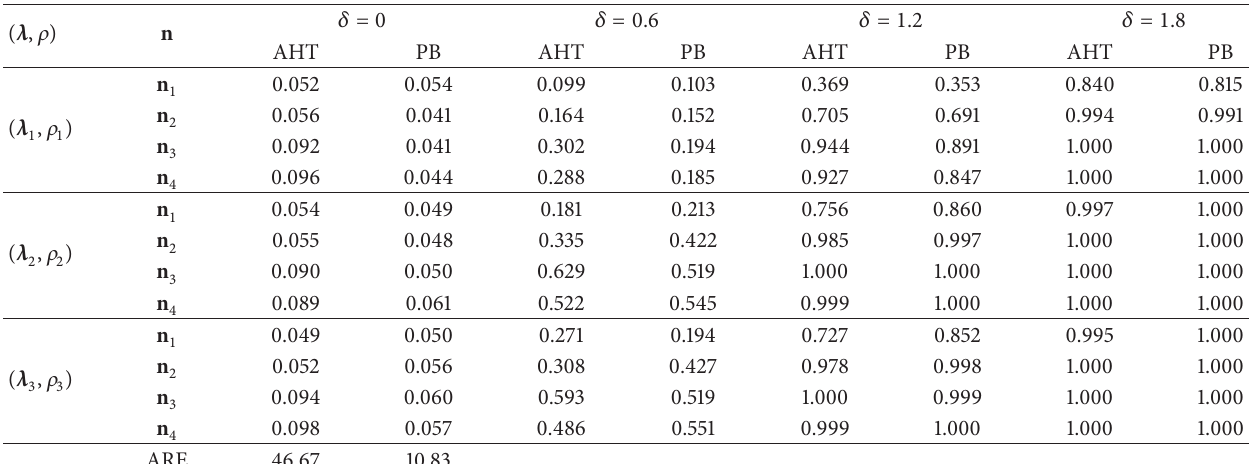
Table 2: Empirical sizes and powers of the two tests for nested effects for 3-variate two-factor multivariate nested designs [ 𝑎 = 3, 𝑏 1 = 8, 𝑏 2 = 10,